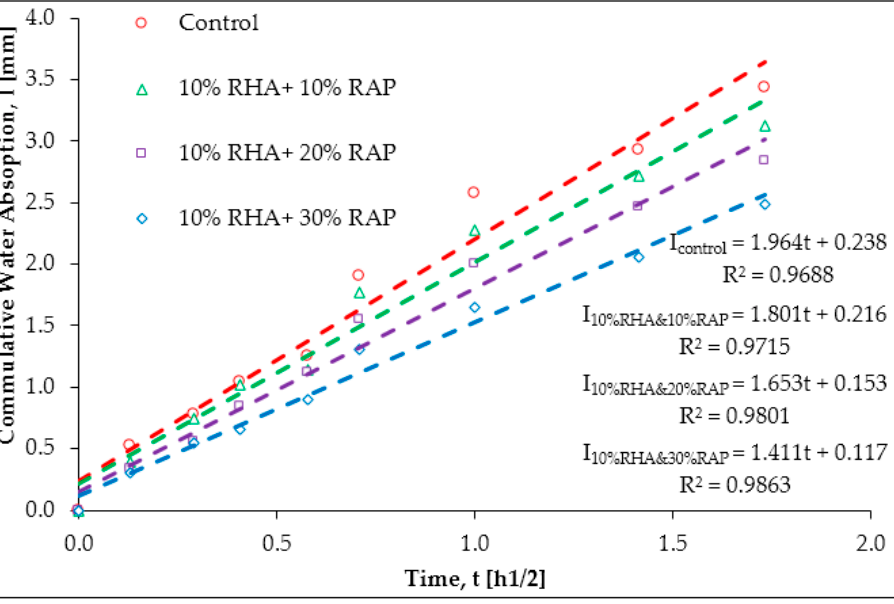
Figure A4. Cumulative water absorption by 10% RHA and (10–30) % RAP-inclusive concrete.